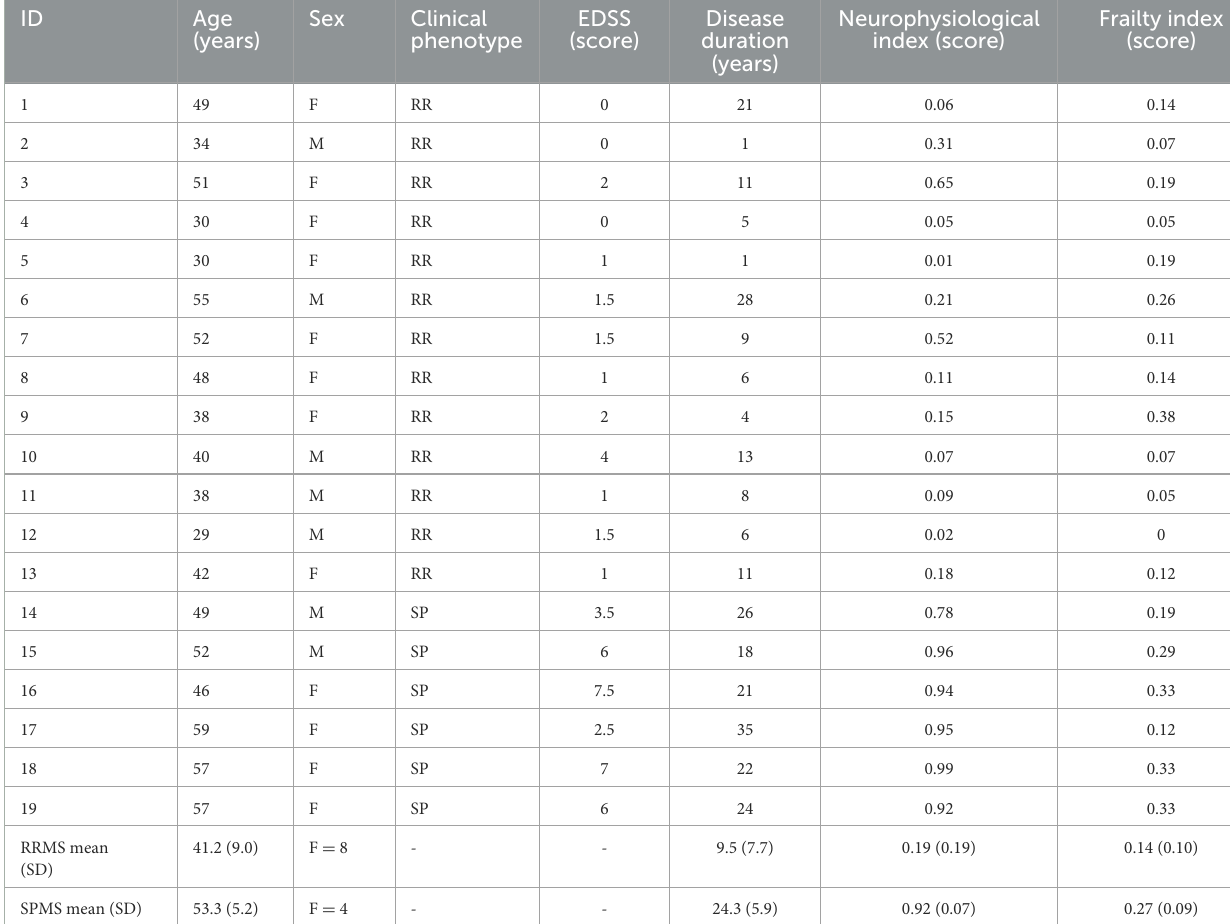
TABLE 1 Patients’ demographic, neurophysiological and frailty